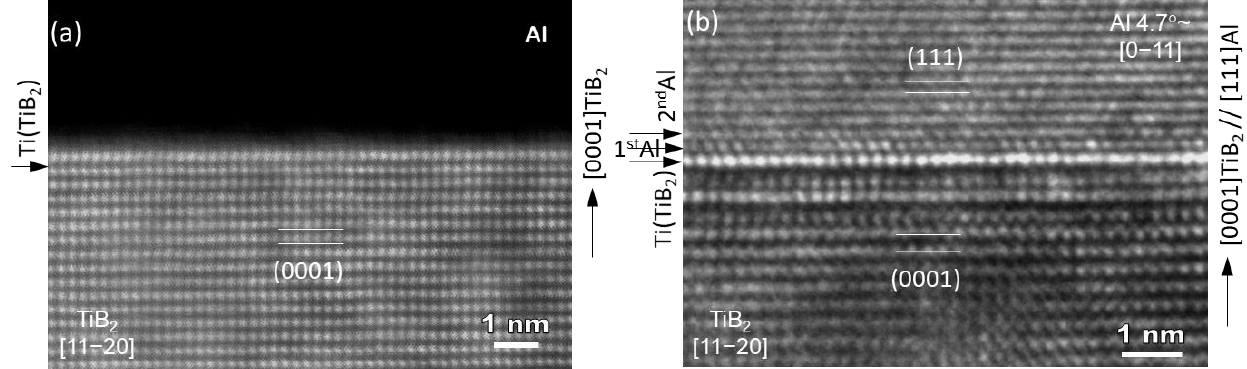
Figure 3. The interface between Al and a synthetic TiB 2 particle. HR-STEM images showing that ( a ) no particular orientation relationship (OR) between Al and TiB 2 and ( b ) (1 1 1)Al and (0 0 0 1)TiB 2 planes are paralleled to each other and a deviation of 4.7° between [0 1̅ 1]Al and [1 1 2̅ 0]TiB 2 directions [55]. The OR is: (0 0 0 1)TiB 2 // (1 1 1)Al, [1 1 2̅ 0]TiB 2 4.7°~ [0 1̅ 1]Al. However, there is no such deviation between the first Al layer (as indicated) and the TiB 2 .